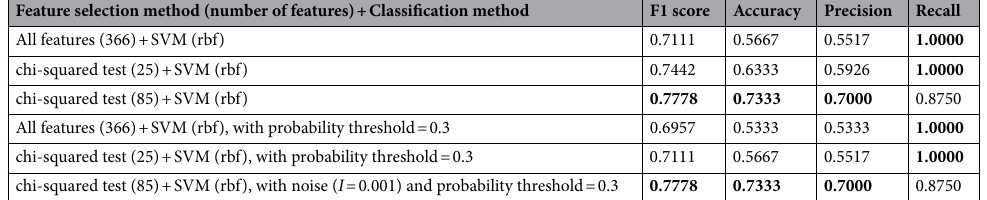
Table 3. The first and second methods used microbiota data only. The first method trained the model on the original training set without feature selection. The second method did feature selection by chi-squared test and selected 25 features, while the third method used both transcriptome and microbiota data, and integrated the data using the fourth plan mentioned above, and selected 85 features (35 for transcriptome and 50 for microbiota). For the last three methods, they are similar with the first three methods respectively. The only difference was that they changed the threshold and added